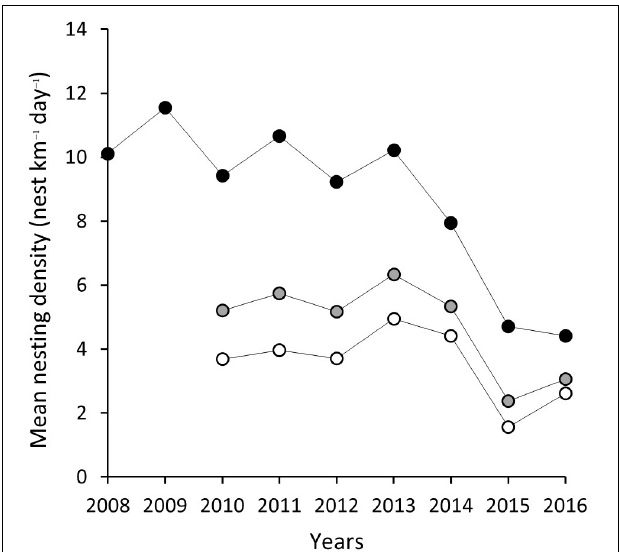
FIGURE 3 | Mean nesting density (nests km − 1 day − 1 ) for index beaches